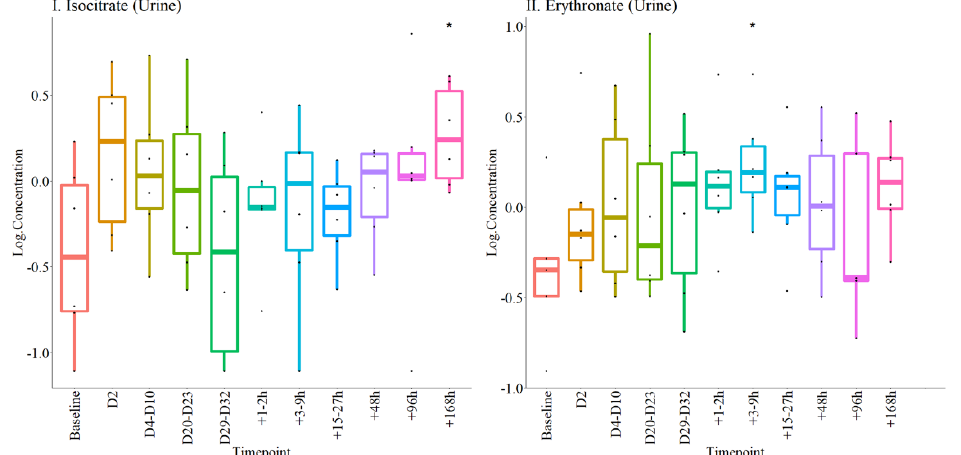
Figure 8. Urine concentrations of metabolites altered at different time points during the experiments. The log concentrations of each metabolite at different time-points are plotted separately as labelled in I and II. * p < 0.05, compared with baseline.